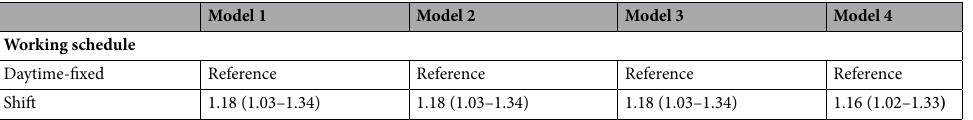
Table 2. Results of a generalized estimating equation analyzing the risk of poor medication adherence. Model 1: adjusted age in observation year and sex. Model 2: adjusted age in observation year, sex, and education. Model 3: adjusted age in observation year, sex, education, and household income level. Model 4: adjusted age in observation year, sex, education, household income level, and occupational classification.